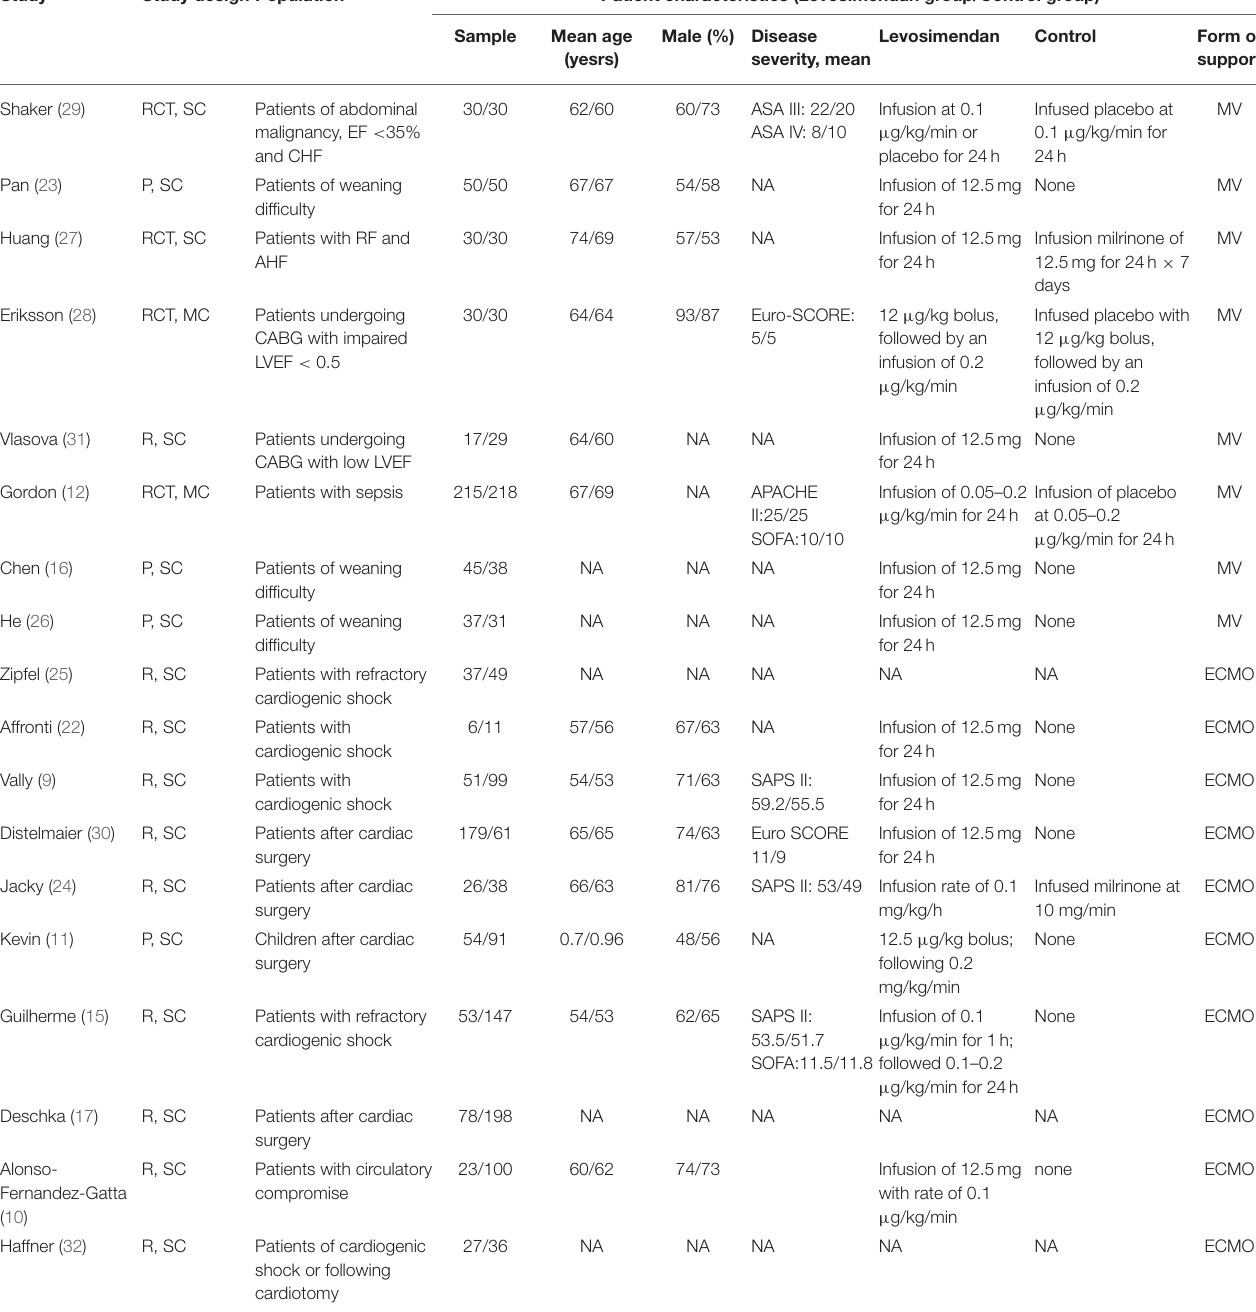
TABLE 1 | Characteristics of the included